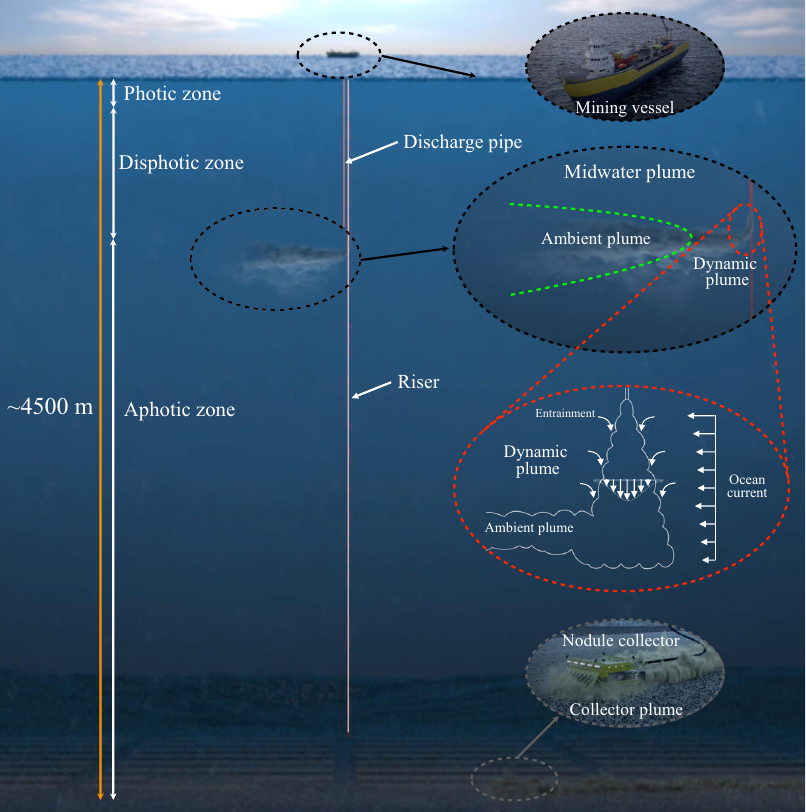
Fig. 1 Schematic of a polymetallic nodule mining operation. From top to bottom, the three zoom-in panels illustrate the surface operation vessel, the midwater sediment plume, and the nodule collector operating on the seabed. The midwater plume comprises two stages: (i) the dynamic plume, in which the sediment-laden discharge water rapidly descends and dilutes to a neutral buoyancy depth, and (ii) the subsequent ambient plume that is advected by the ocean current and subject to background turbulence and